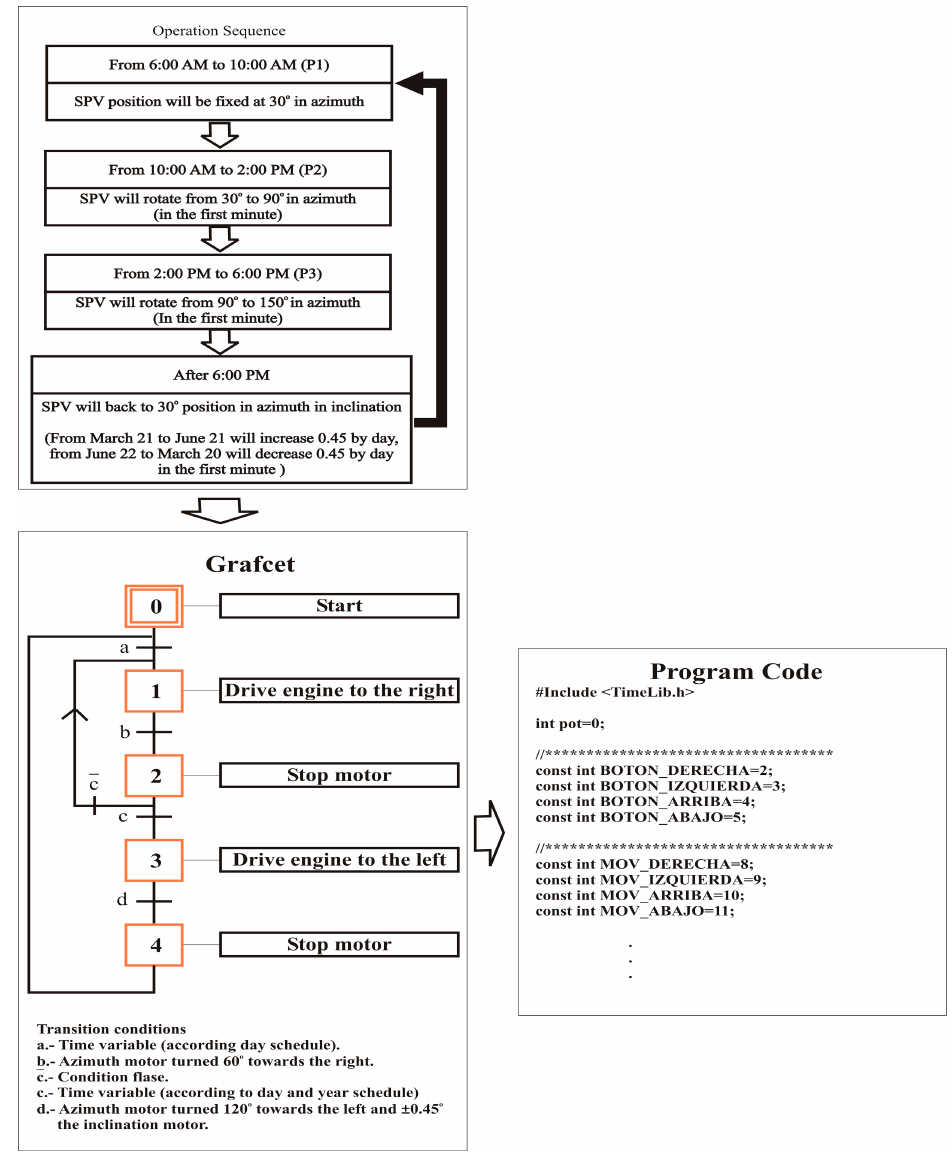
Figure 9. Controller programming process.